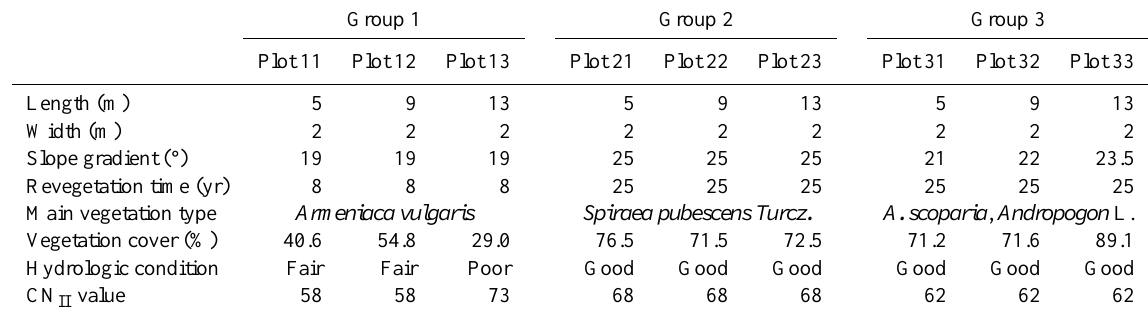
Table 1. Main characteristics of each runoff plot in the three groups.